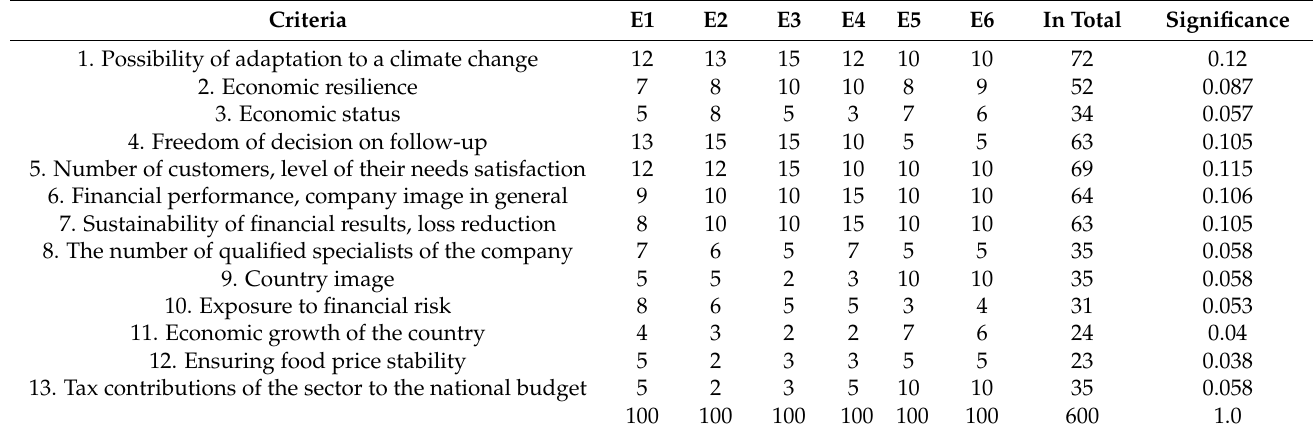
Table 4. Results of experts’ assessment for determination of significance of